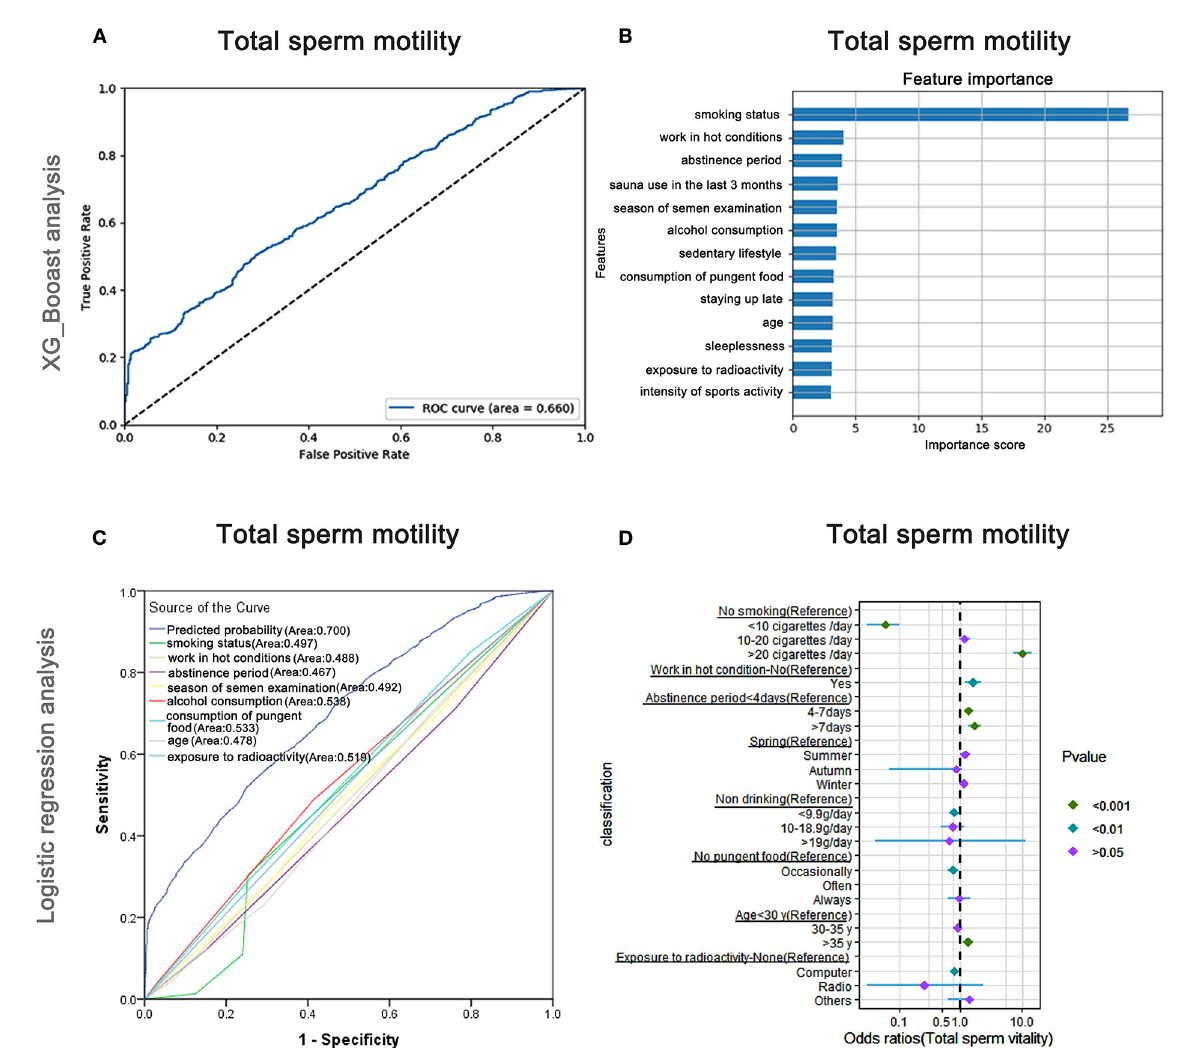
FIGURE6 XGBoost and logistic regression analysis of the risk factors for total sperm motility. The ROC curve (A) and the feature importance (B) analyzed by XGBoost and the ROC curve (C) and forest diagram showing significant risk factors (D) analyzed by logistic